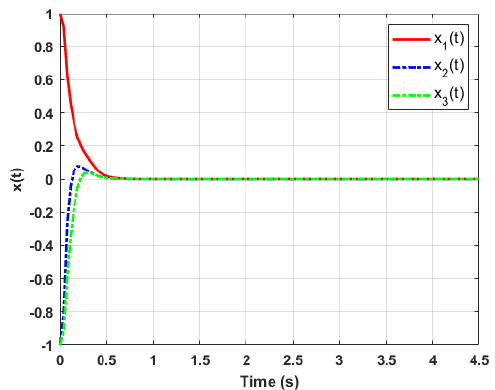
= . Figure 2. State trajectory of the system for Example 2 with θ = − 2.103, τ = 0.6199